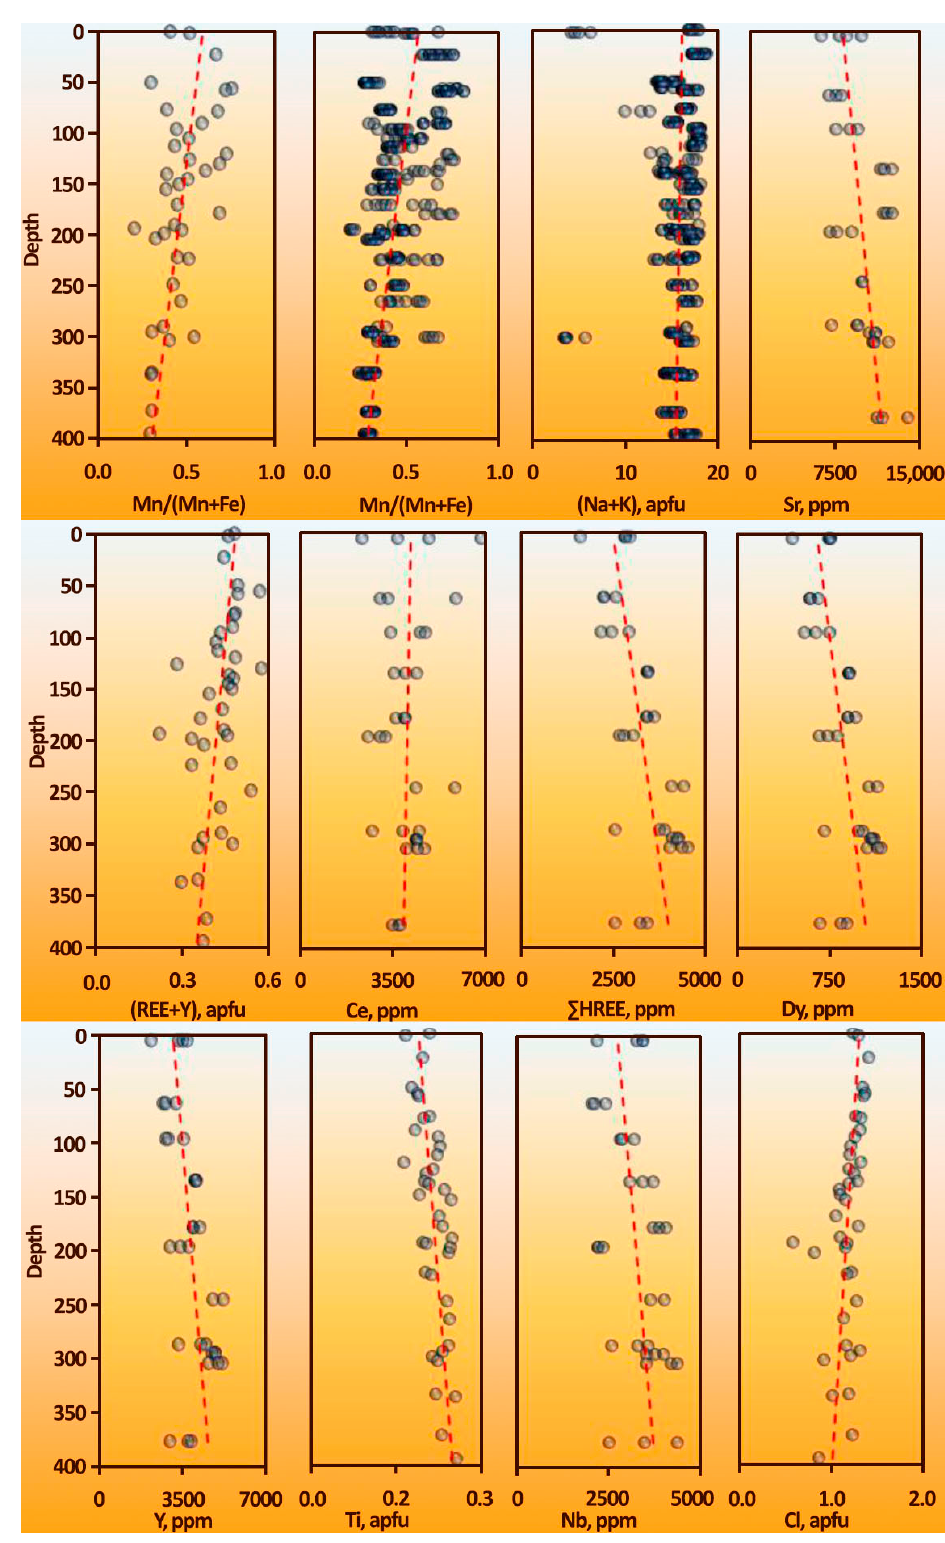
Figure 2. Compositional variations in Lovozero EGM plotted against stratigraphy. The material is collected from drill holes, so 400 m means the deepest part; 0—the top of the section. Ti and Nb contents in EGM vary little in Phase III with Ti decreasing from 0.26 to 0.21 apfu and Nb decreasing from 3400 to 3100 ppm. Cl in EGM increases systematically up- ward from 0.86 to 1.23 apfu, while S decreases from 0.13 to 0.07 apfu. Contents of U and